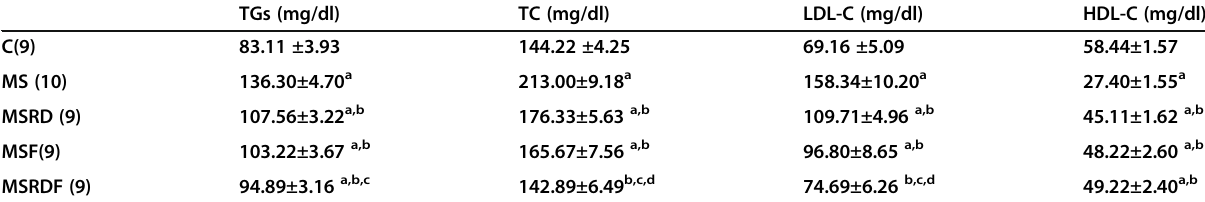
C, control group, MS, untreated metabolic syndrome group, MSRD, metabolic syndrome group reverted to regular rat chow, MSF, metabolic syndrome group on alternate day fasting, MSRDF, metabolic syndrome group reverted to regular rat chow and on alternate day fasting; TGs, triglycerides; TC, total cholesterol; LDL-C, low-density lipoprotein cholesterol; HDL-C, high-density lipoprotein cholesterol Data are expressed as mean ± SEM